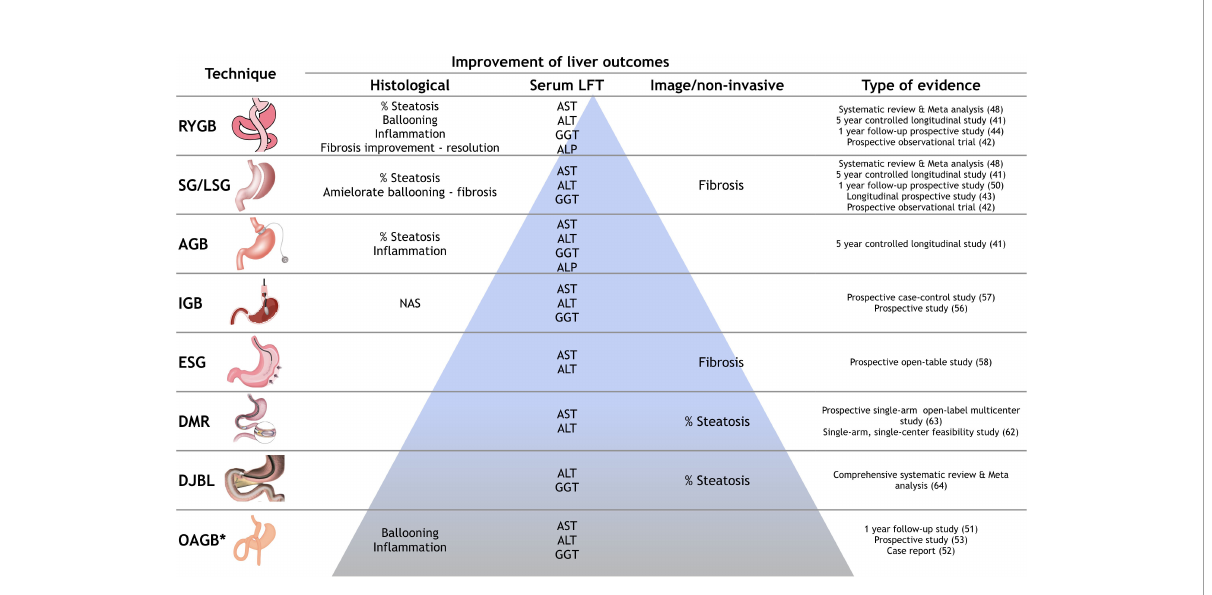
FIGURE 3 Evidence of effect of bariatric endoscopic and surgical procedures in NAFLD outcomes. Bene fi cial effects on liver outcomes of surgical and endoscopic procedures, according to level evidence (pyramid). LFT, liver function test; RYGB, Roux-en-Y gastric bypass; SG, sleeve gastrectomy; LSG, laparoscopic sleeve gastrectomy; AGB, adjusted gastric band; IGB, intragastric ballon; ESG, endoscopic sleeve gastroplasty; DMR, duodenal mucosa resurfacing; DJBL, duodenal jejunal bypass liner; OAGB, one anastomosis gastric bypass; AST, aspartate aminotransferase; ALT, alanine aminotransferase; GGT, gamma-glutamyl transpeptidase; ALP, alkaline phosphatase. *Results of 3